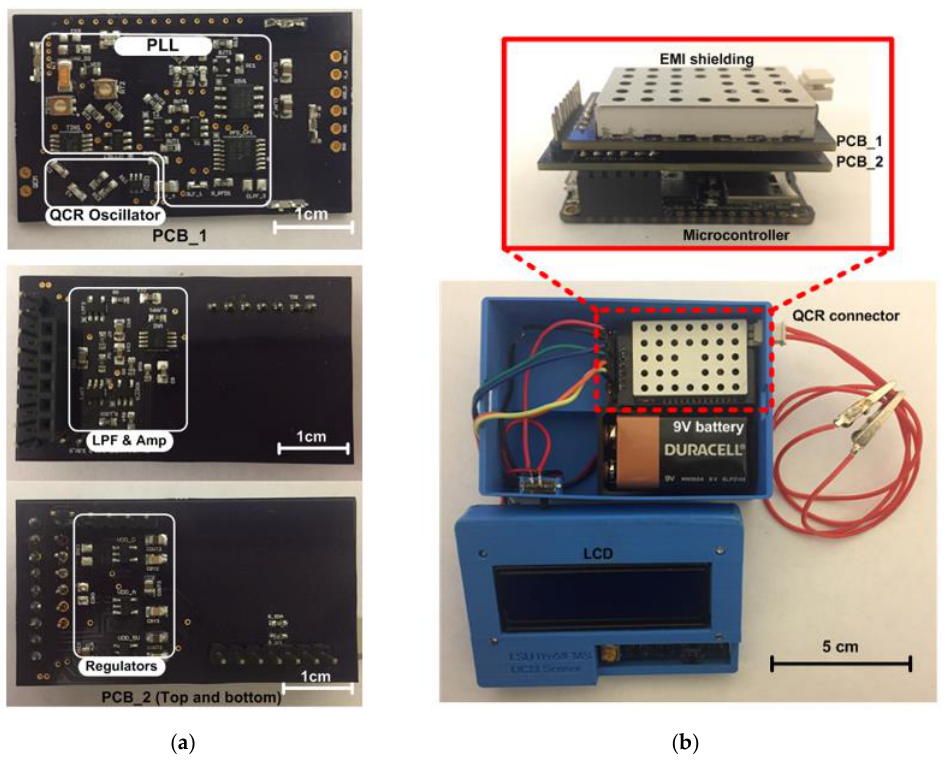
Figure 2. Developed miniaturized QCM measurement system including custom-designed PCBs: ( a ) designed PCBs (PCB_1 and PCB_2) and ( b ) developed system inside a 3-D printed housing.